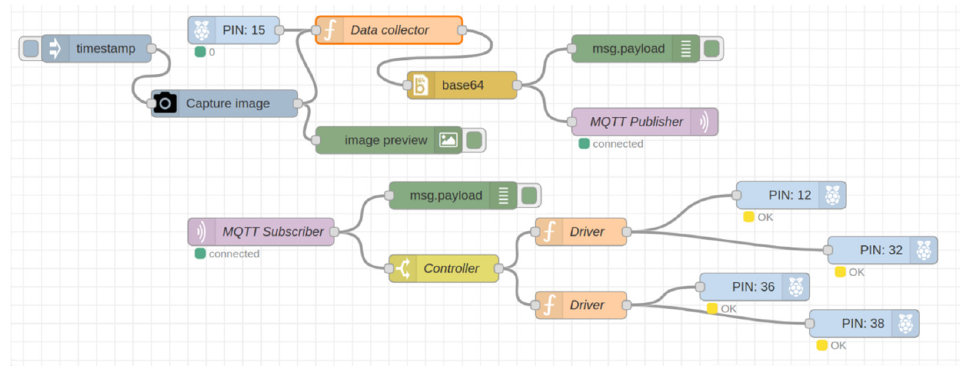
Figure 9. Implemented data flow in the robot local station in the Node-RED environment.